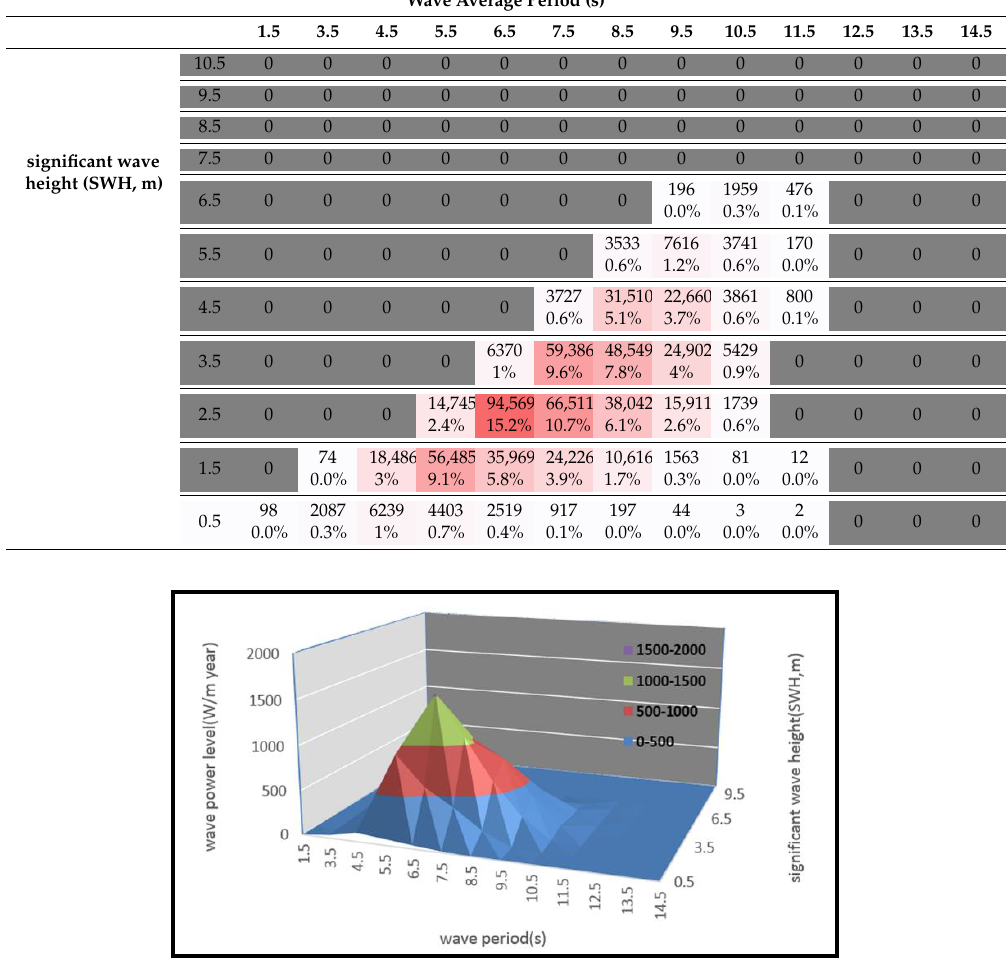
Figure 3. Surface chart of the wave power level for the South China Sea.